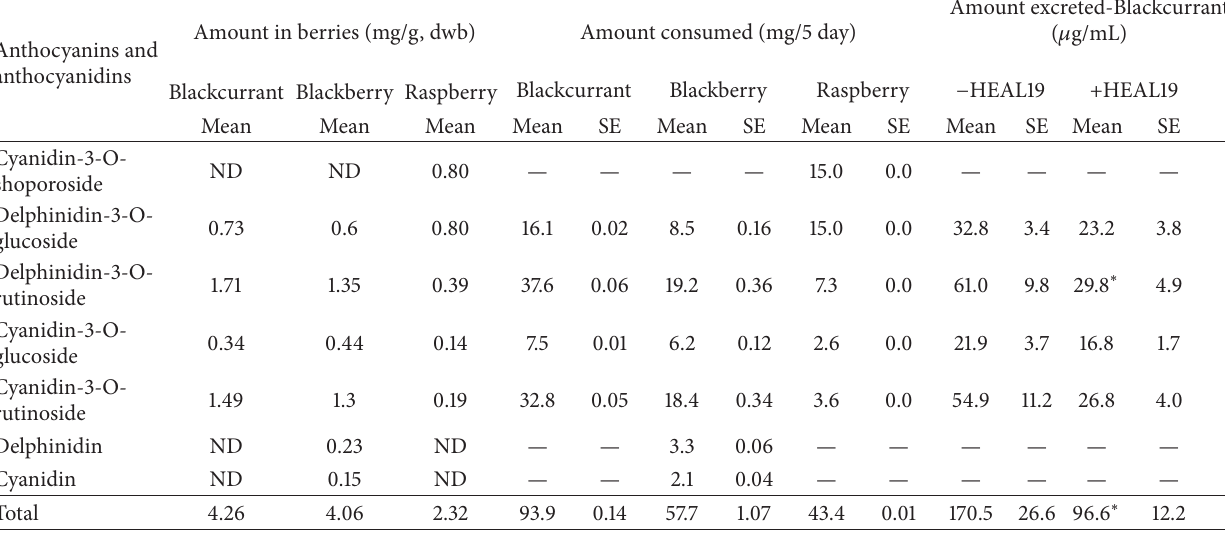
Table 6: Anthocyanins and anthocyanidins detected with LC-ESI-MS from blackcurrant, blackberry, and raspberry (mg/g, dwb), with